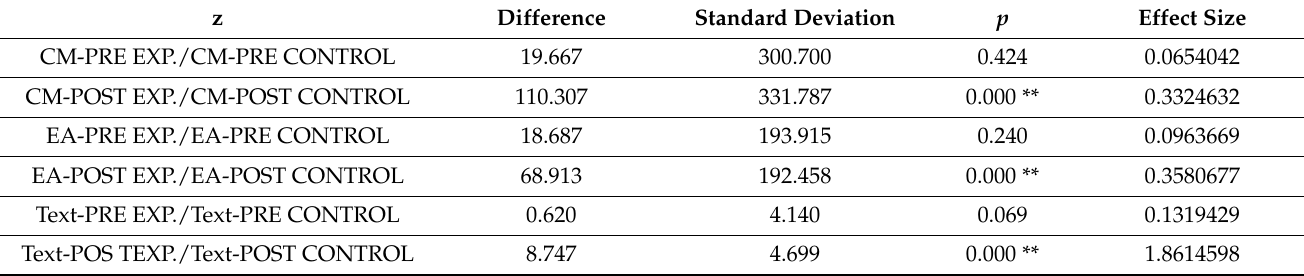
Table 12. Contrast for related samples between the control group and the experimental